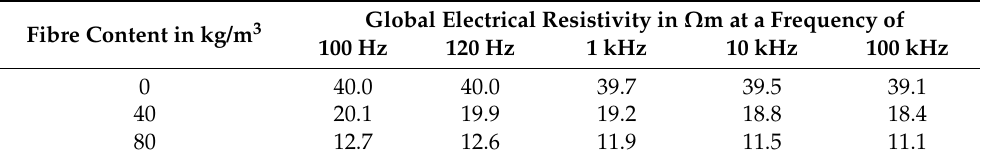
Table A35. Results of the resistivity measurements of the concrete mixture 32-60-300-00 after storage in H2O for 7 days for the investigations of possible leaching effects.